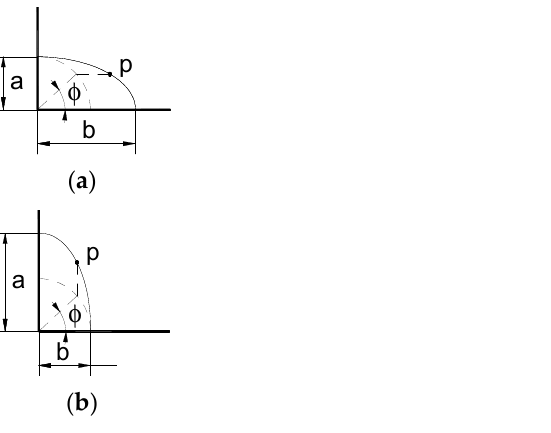
Figure 2. Angle ϕ defining a point p of the crack front: ( a ) a / b ≤ 1; ( b ) a / b > 1.